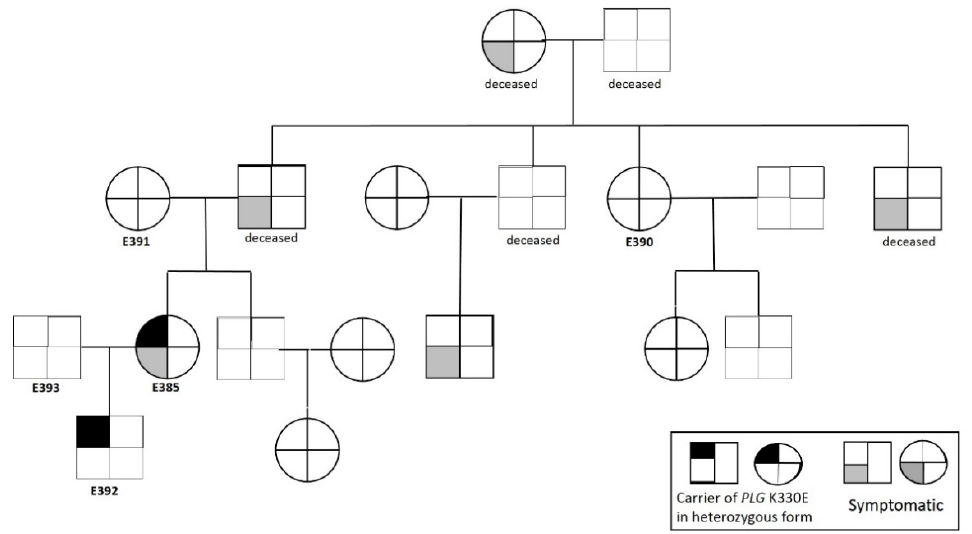
Figure 1. Family tree of the index case. Blood samples were available only from the subjects labelled with numbers (E385, E390, E391, E392, E393), they were screened for the PLG K330E mutation by Sanger-sequencing.